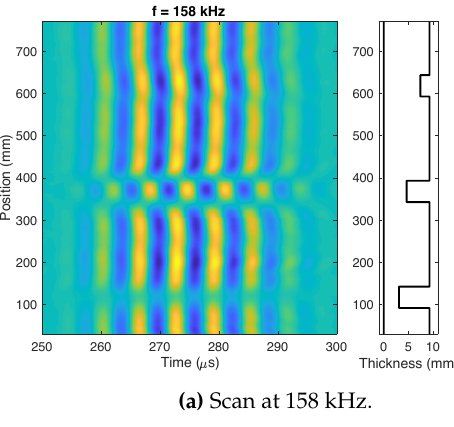
Figure 13. Axial scan of the real pipeline at two frequencies.